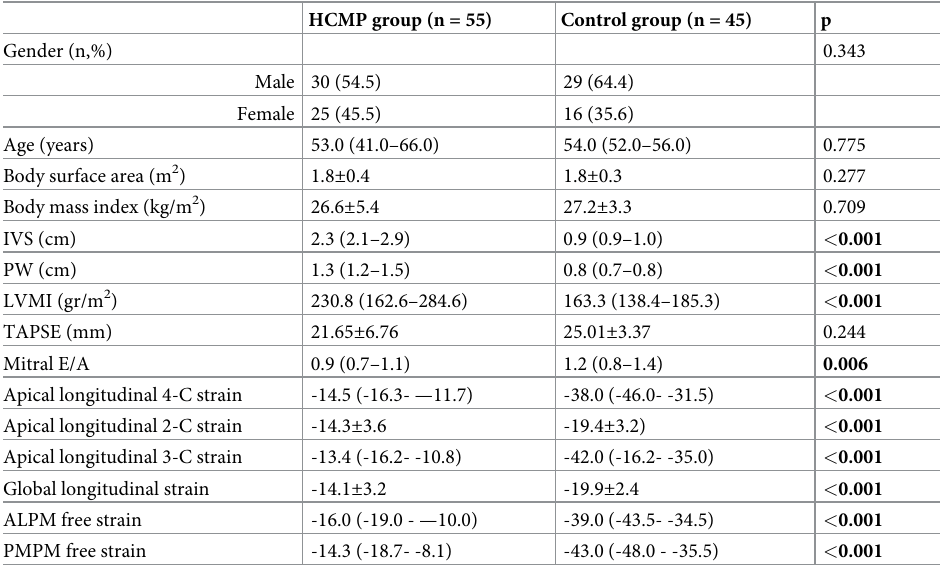
Table 1. Clinical and echocardiographic characteristics of the two groups.